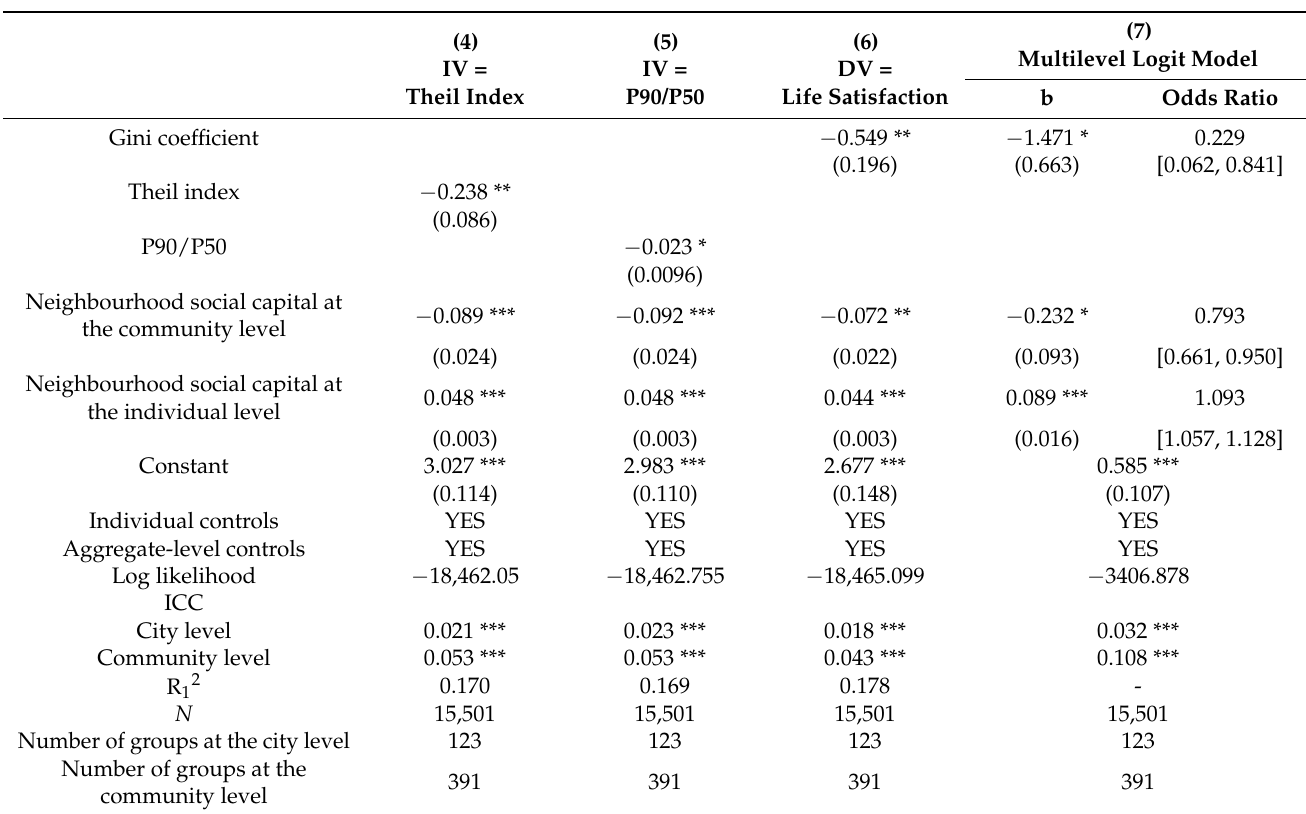
Table 4. Robustness